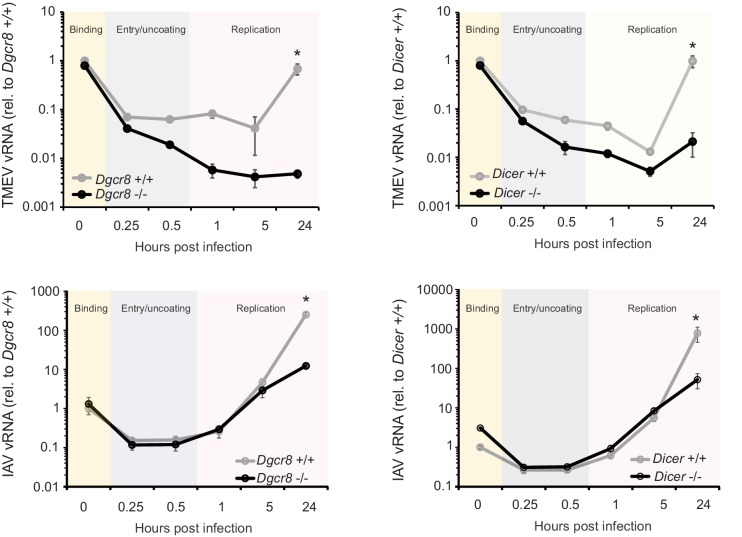
Viral entry in miRNA-deficient and wild-type ESCs.To rule out morphological changes affecting the outcome of viral infections, a binding and entry assay was performed. Cells were infected at 4°C which inhibits entry of viral particles, but allows binding of virions. At t = 0, cells are moved to 37°C resulting in a synchronized entry of virus particles allowing an accurate quantification of how much virus enters the cell and virus replication kinetics. Cells were infected with either TMEV (top panels) or Influenza A virus (bottom panels) and viral RNA was quantified by qRT-PCR. For all viruses, binding was comparable in all cell lines. Differences in TMEV kinetics were greater soon after the entry phase and continued to increase towards the end of the experiment. Differences in IAV became most apparent late in the replication phase, possibly because IAV is very proficient in knock down the IFN response in its host cells. Data show the average (n = 3)±s.d, (*) denotes p-value.